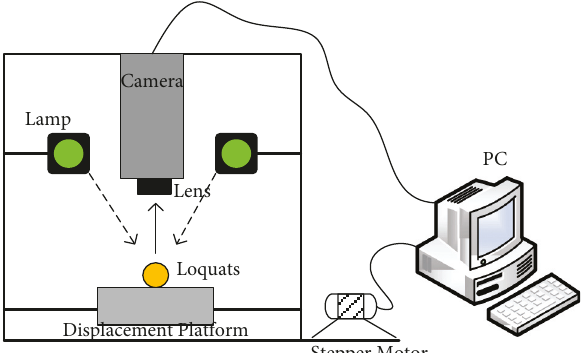
Figure 3: Schematic of hyperspectral imaging system.